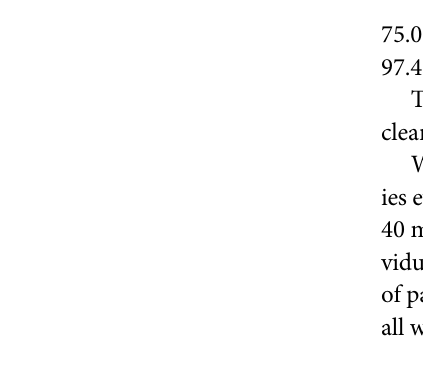
Fig 1. Distribution of raw egg count at baseline by Schistosoma species and study. A. Schistosoma haematobium . B. Schistosoma mansoni . C. Schistosoma japonicum .